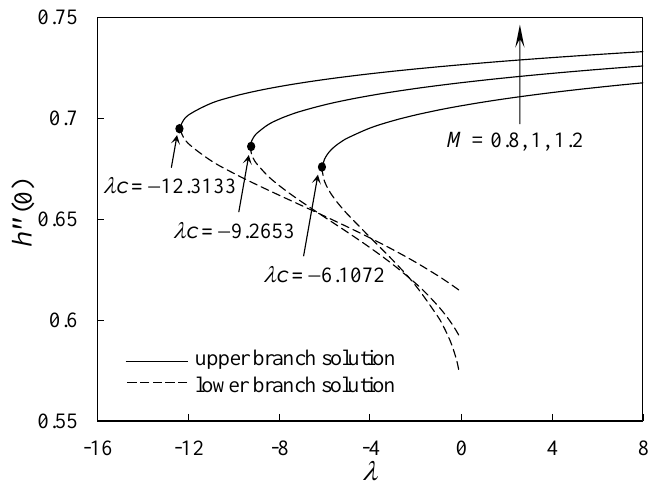
Figure 16. Variation of h (cid:48)(cid:48) ( 0 ) with λ for several values of M for Cu-water nanofluid.